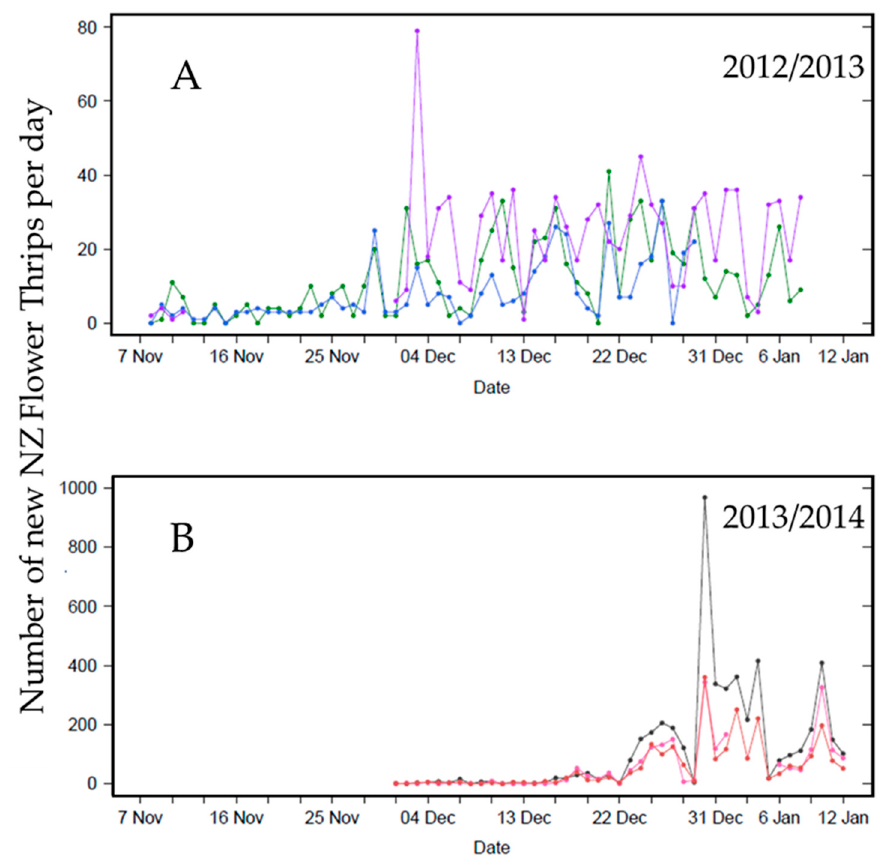
Figure 2. Number of New Zealand flower thrips (NZFT) caught each day over the peak population growth period for two seasons ( A ) 2012 / 2013 and ( B ) 2013 / 2014 in three self-reporting camera traps in a Central Otago, New Zealand stone-fruit orchard. Each color represents a trap.